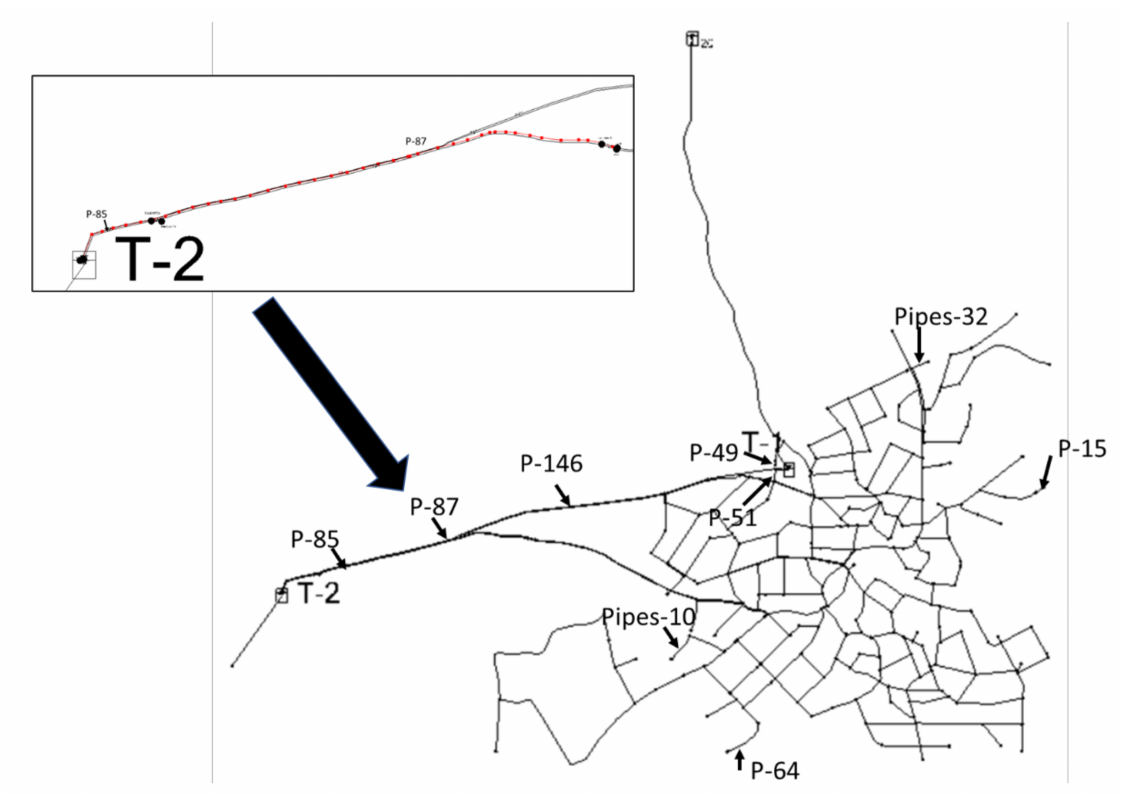
Figure 3. Critical pipes studied in the chlorination scenarios.